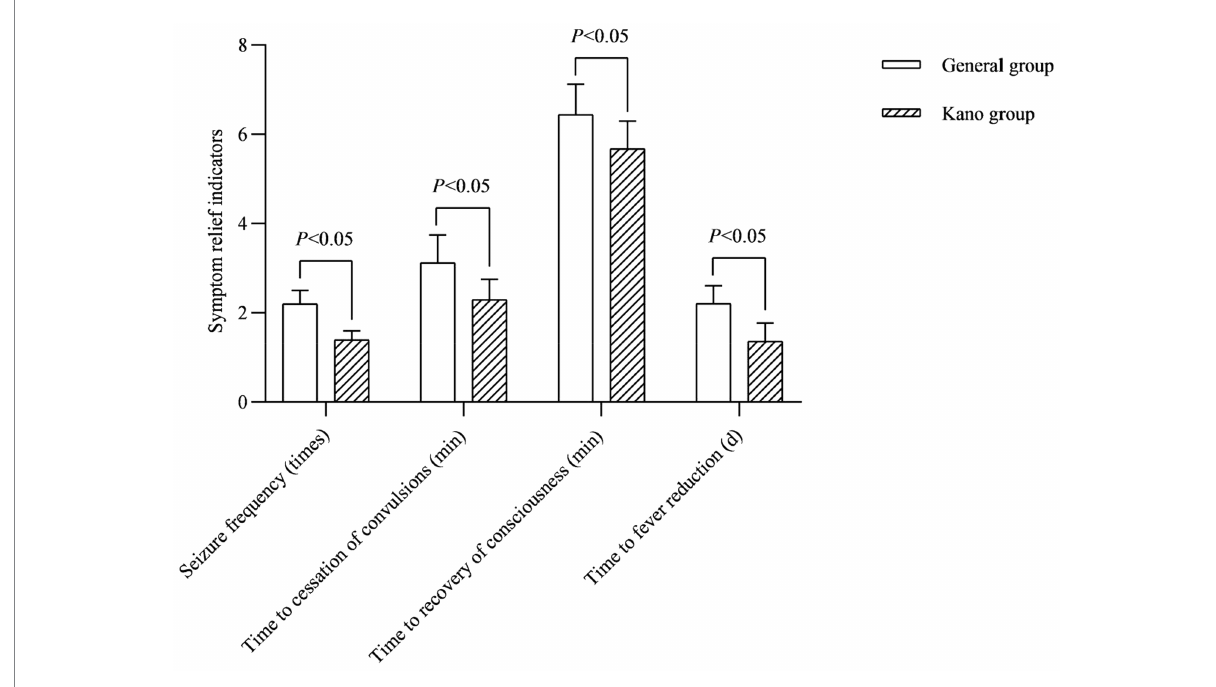
FIGURE 1 Symptom relief indicators for